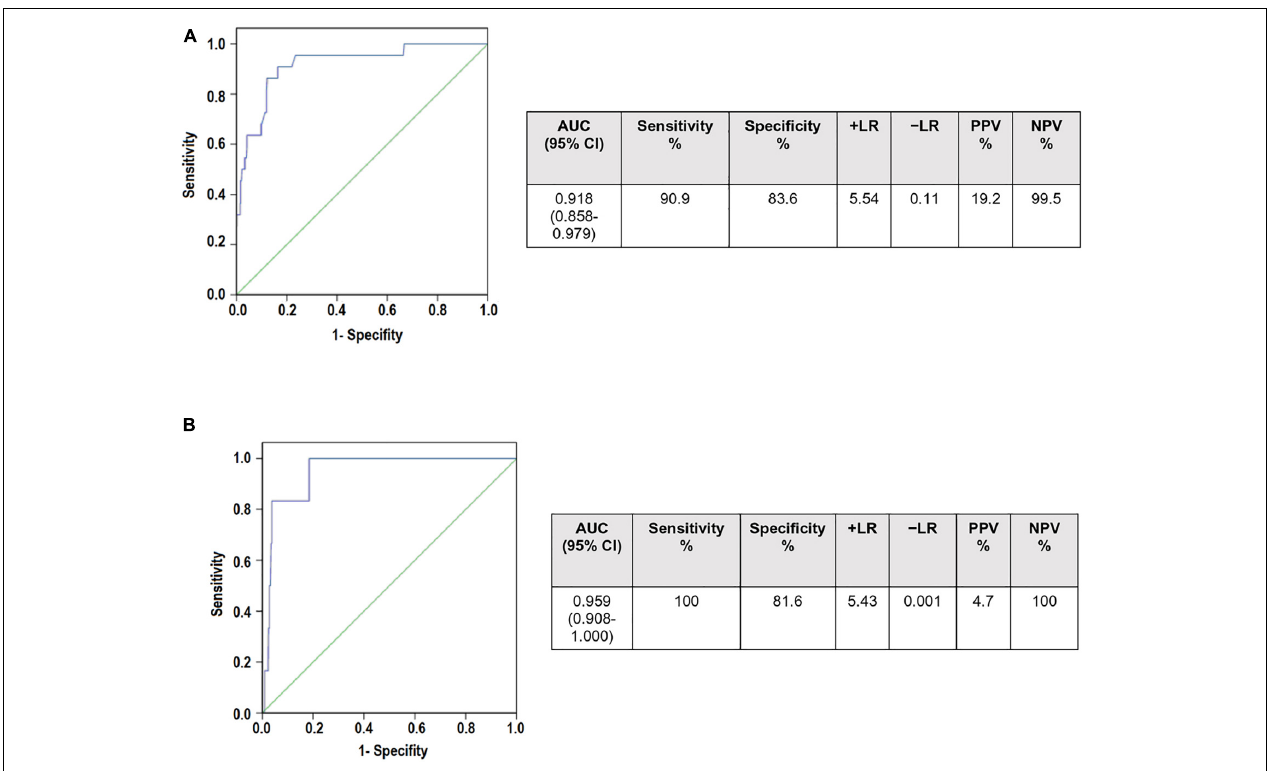
FIGURE 2 | Receiver operating curves (ROC) curves to determine the diagnostic utility of serum uric acid ratio in (A) Preeclampsia (B) Preeclampsia Group A (who develop preeclampsia before 34 weeks of gestation). AUCs for both curves were > 0.9 showing that UAr may be a good screening tool. However, it has very low positive predictive values (19.2 and 4.7, respectively). In contrast, the negative predictive values were 99.5% for preeclampsia and 100% for Group A of preeclampsia. Area under the curve (AUC), confidence interval (CI), Positive Predictive Values (PPV) Negative Predictive Values (NPV), probability indices